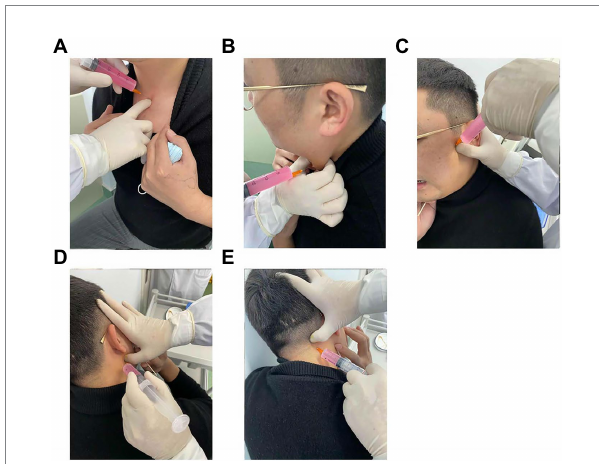
FIGURE 1 Latent MTrPs injection for CVA. Sternoclavicular joint latent MTrPs injection (A) . Sternocleidomastoid muscles latent MTrPs injection (B) . Medial or lateral pterygoid muscles latent MTrPs injection (C,D) . Splenius capitis muscles latent MTrPs injection (E) . MTrPs, myofascial trigger points; CVA, cough variant